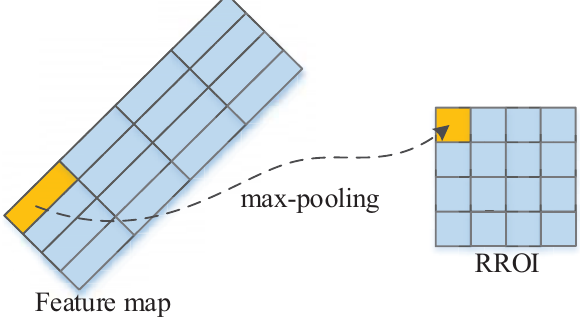
Figure 7. Rotation RoI pooling.